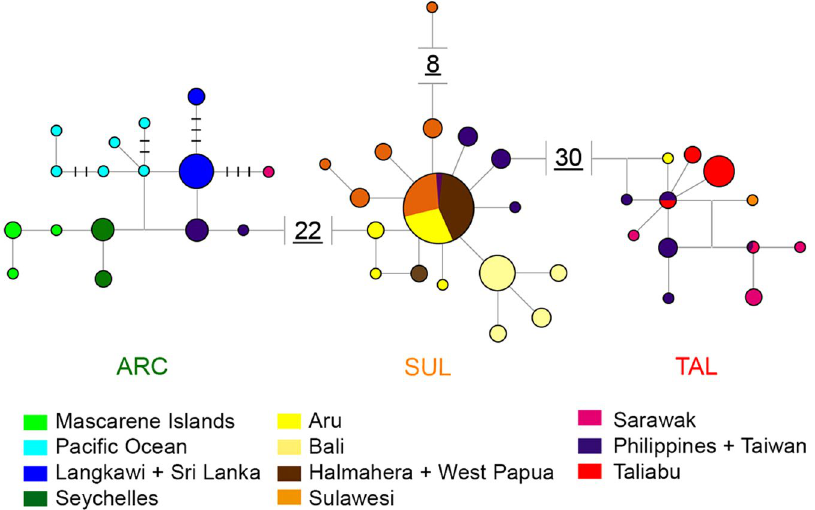
Figure 3. Mitochondrial 16S haplotype network. A single substitution step is represented by a single line connecting two haplotypes. Any number of steps between two and five is represented by the number of dashes on the line connecting two haplotypes. Any distance higher than five steps is represented by the written number of steps. Non-sampled intermediary haplotypes are represented by empty vertices connecting three or more haplotypes. Each colour represents a region according to the